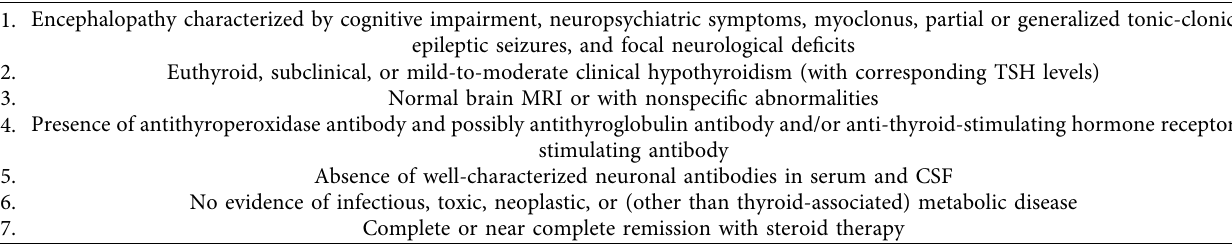
Table 1: Diagnostic criteria for SREAT [6, 14].